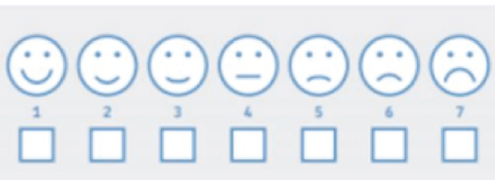
Figure 8: Satisfaction questionnaires in the second intervention for children in the 2nd and 4th grades (primary school).